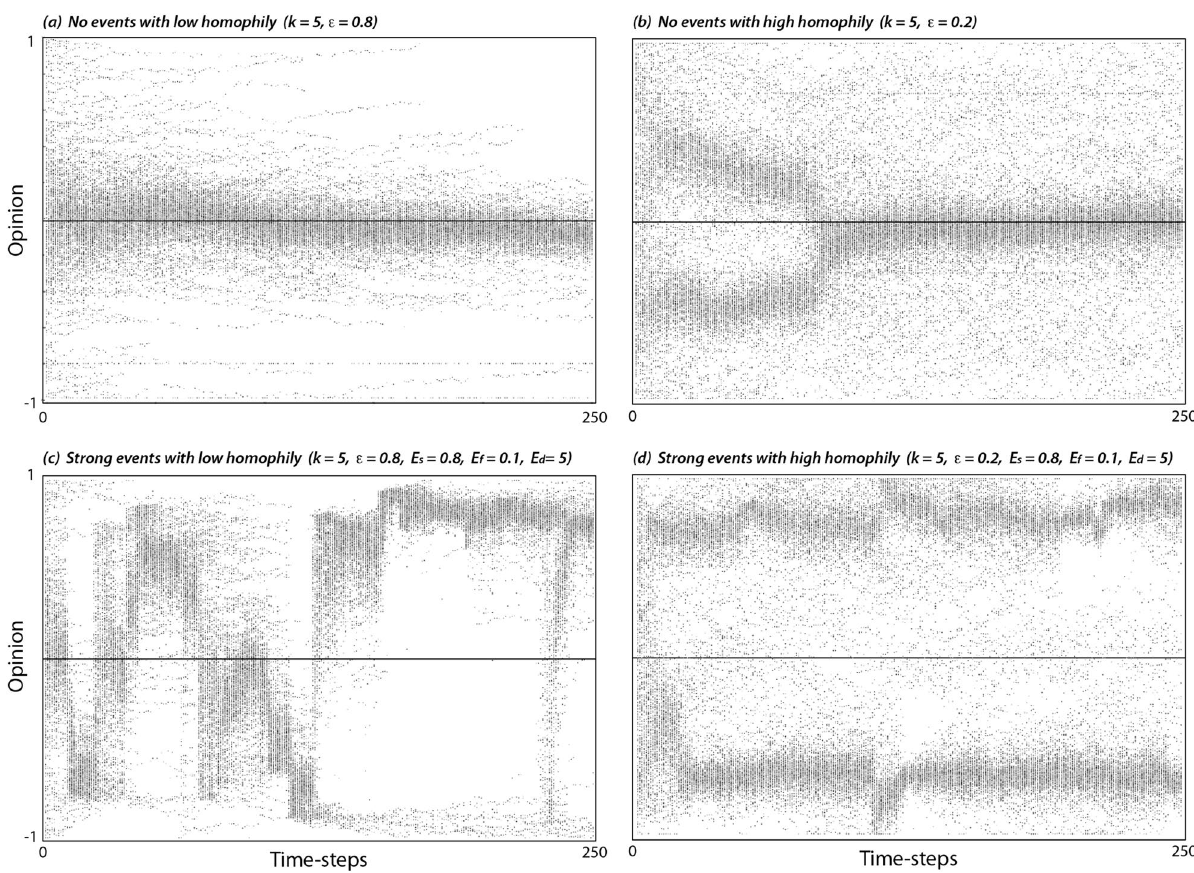
Figure 2. Opinions of individuals starting from a random distribution [− 1 1] under a range of conditions (first 250 timesteps